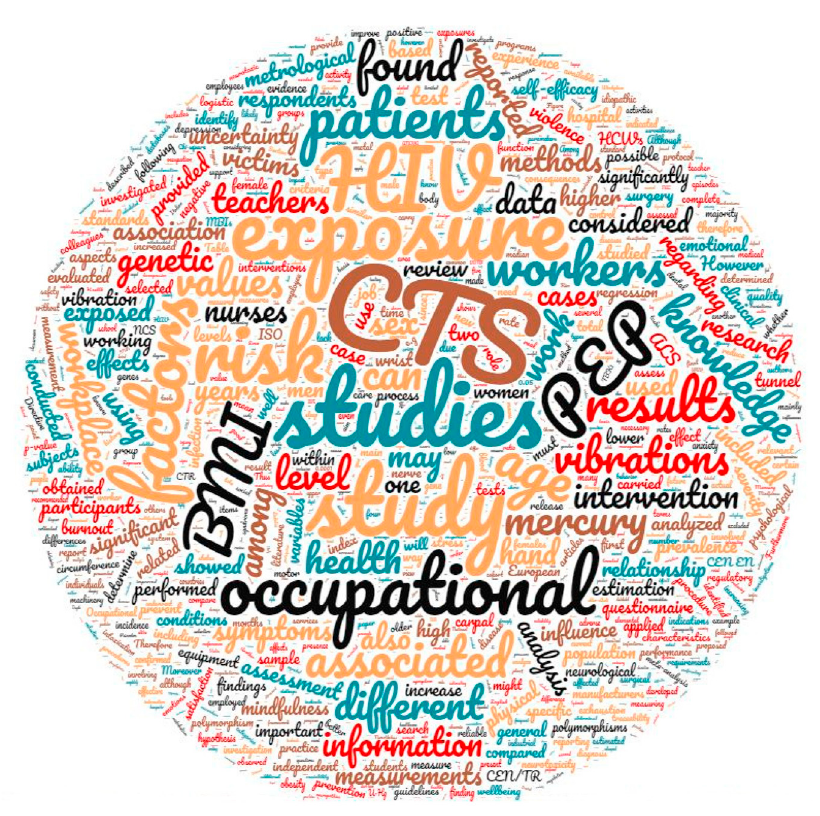
Figure 1. Word cloud generated from the full text of each publication of the Special Issue.